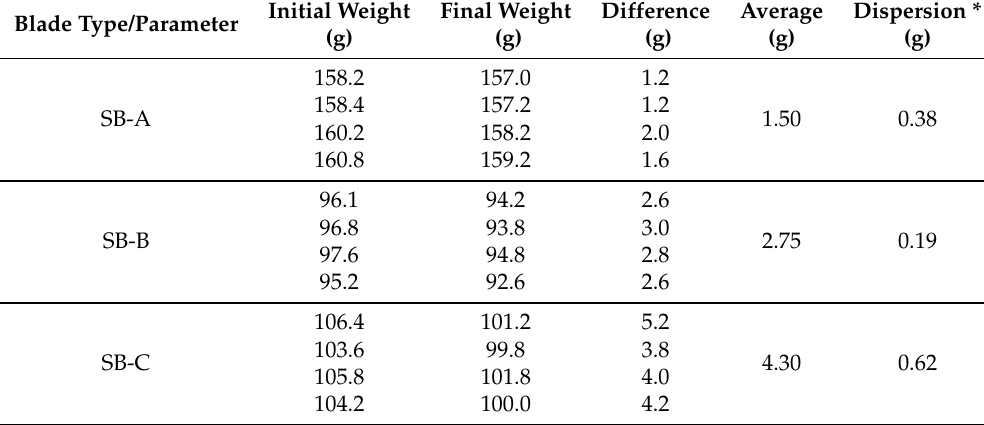
Table 4. Tool wear analyses by measuring the weight loss difference.